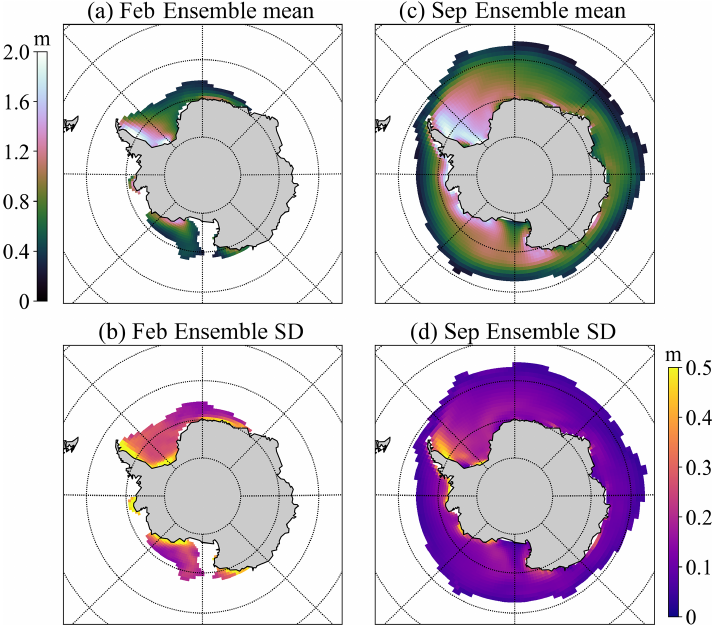
Figure B3. (a) Ensemble model mean February sea ice thickness climatologies (only SIC > 15% are shown) and (b) the standard deviation. (c, d) The same as (a, b) but for